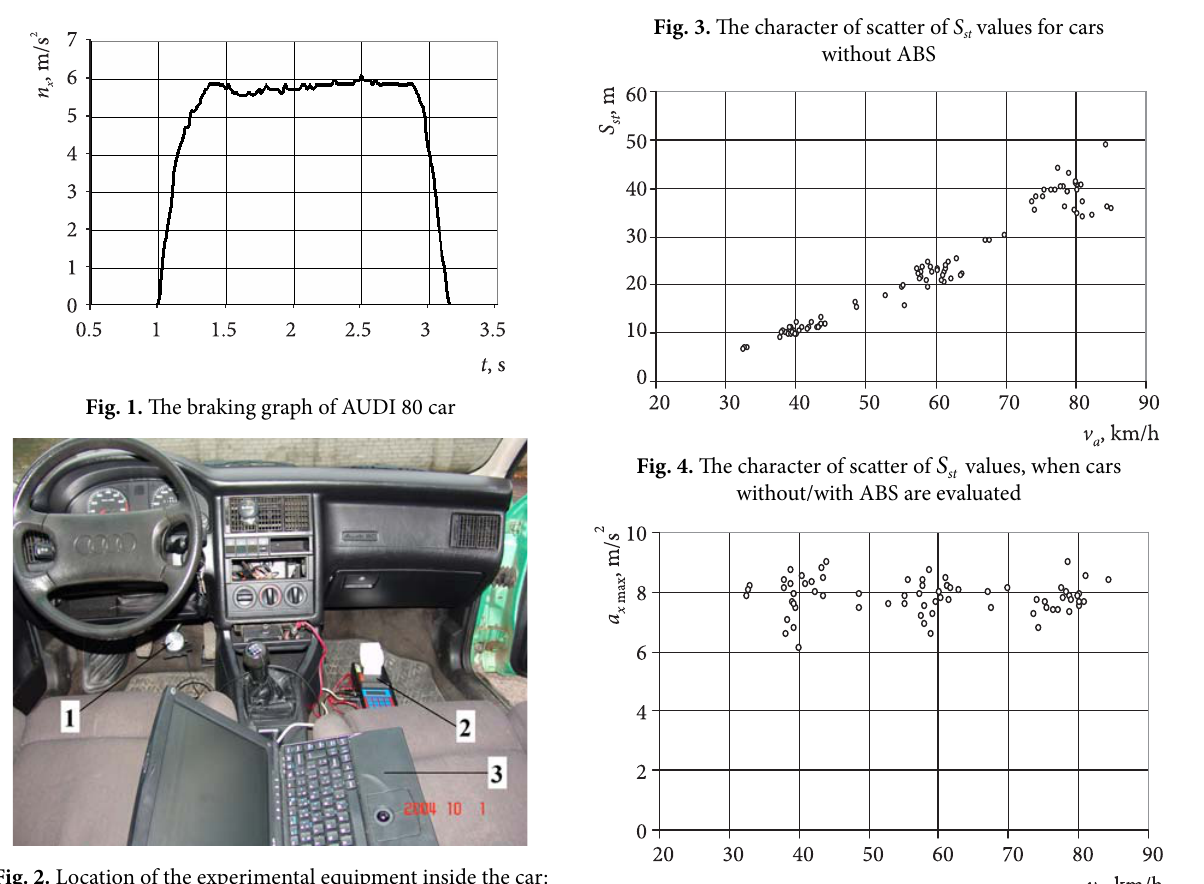
Fig. 3. Th e character of scatter of S